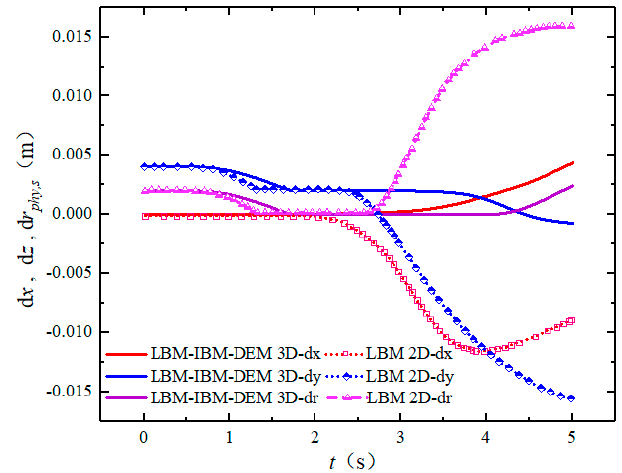
Figure 8. The variation of d x , d z , and d r s in three methods.